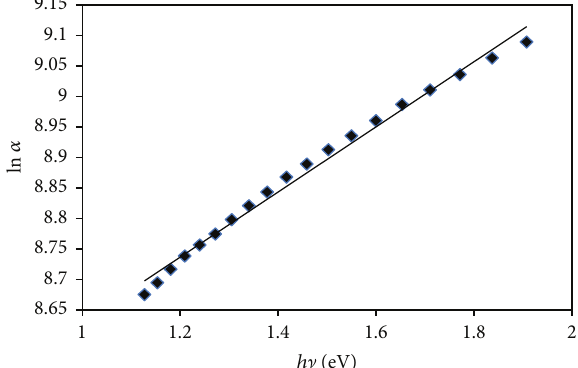
Figure 7: ln 𝛼 versus ℎ ] for determination of the localized tail state 𝐸 𝑒